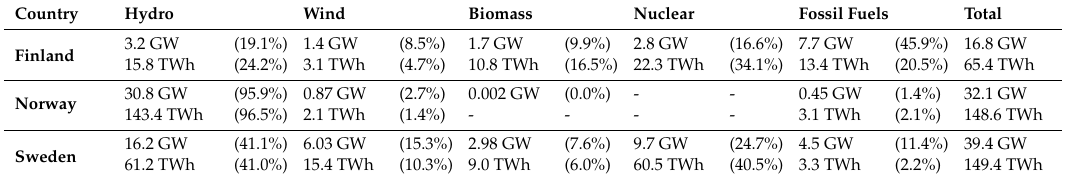
Table 2. Installed capacity, electricity generation and %—shares in Finland, Norway, Sweden in 2016 [15]. Country Hydro